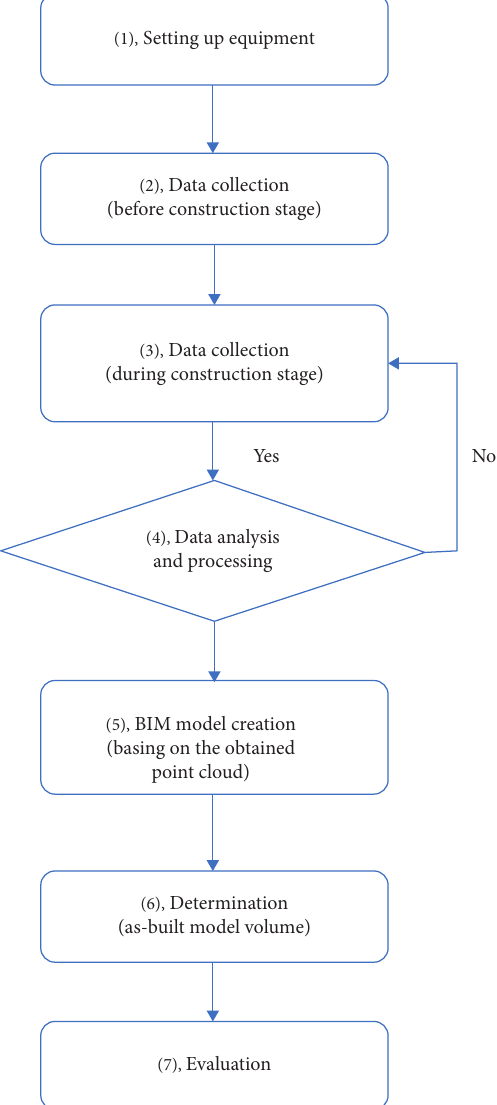
Figure 2: BIM-3D laser scanning